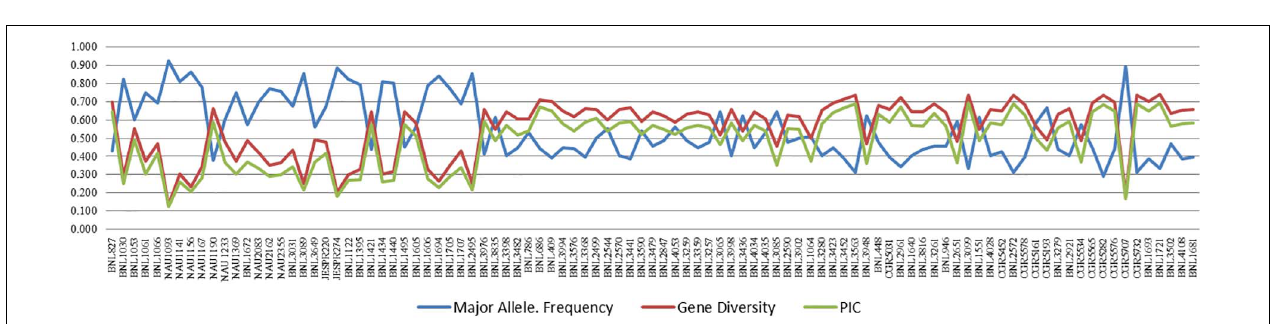
FIGURE 1 | Phenotypic correlations of lint yield contributing traits over six different environments: (A) early sown-2018, (B) early sown-2019, (C) normal sown-2018, (D) normal sown-2019, (E) late sown-2018, and (F) late sown-2019. DF, days to flower; PH, plant height; BW, boll weight; NB, number of boll per plant; NM, number of monopods per plant; GOT, ginning out turn; SI, seed index; SCY/P, seed cotton yield per plant; LY, lint yield; LI, lint index. Here, in the figure upper diagonal and lower diagonal are the same blue and red color highlights for positive and negative correlation, respectively. Correlations significant at p < 0.05 are marked by square in the box. The size of the dots represents the strength (value) of correlation; i.e., the bigger the dots, the higher the value of correlation (toward +1 or -1 for blue and red color, respectively).